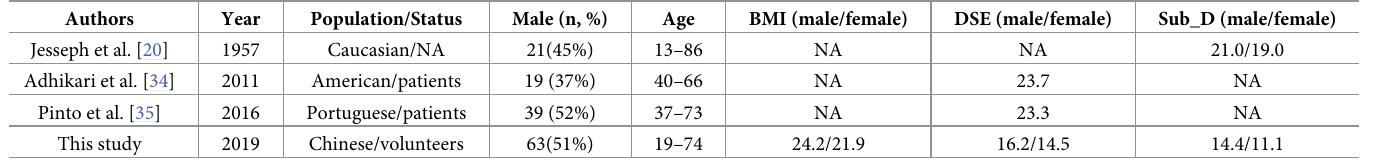
Table 3. Literature review of DSE and subglottic diameter using